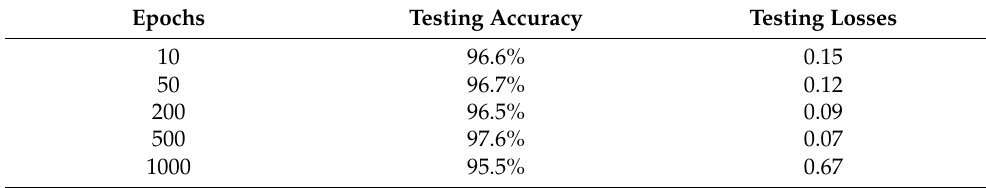
Table 3. Testing accuracy and testing losses for multiple number of epochs values.